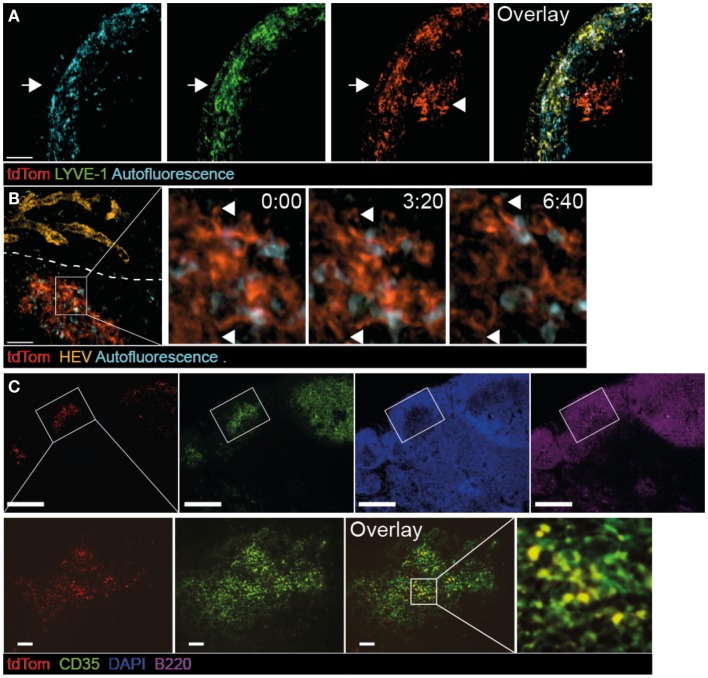
Co-localization of tdTom+ signal with FDCs in TDLNs. B16.F10-tdTom+ cells were s.c. injected into C57BL/6 mice on day 0 and allowed to proliferate for 30 days. Anti-LYVE-1 mAb was injected s.c. one day before 2PM analysis, while anti-PNAd (MECA-79) mAb was injected i.v. on the day of the 2PM experiment. (A) 2PM projection showing intranodal localization of tdTom+ signals (arrowhead) below the SCS region after LYVE-1 labeling. The arrow shows the outer capsule. Scale bar, 50 μm. (B) 2PM projection showing close proximity of tdTom+ structures with macrophages identified by autofluorescent signal and in regions that do not contain HEVs of the T cell area. The time-lapse sequence shows the dendrite-like shape of tdTom+ structures (arrowheads). Scale bar, 50 μm, time in minutes and seconds. (C) Immunofluorescent PLN section showing overlap of tdTom+ signals with the FDC-marker CD35 inside B cell follicles identified by B220 staining. Scale bars, 100 μm (top) and 20 μm (bottom).